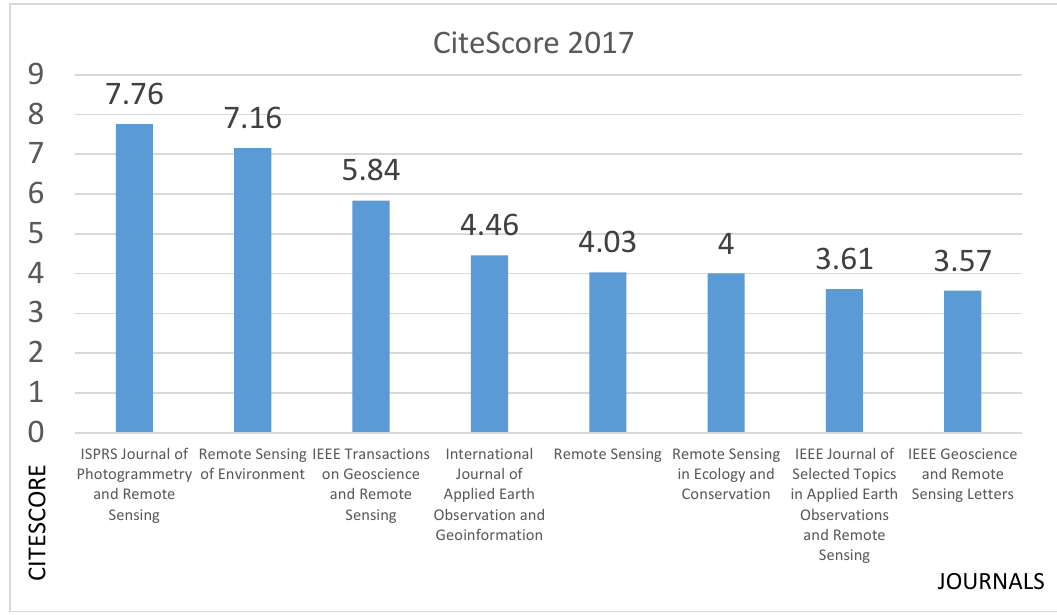
Figure 4. CiteScore, another measure of impact of the journals developed by the publisher Elsevier.